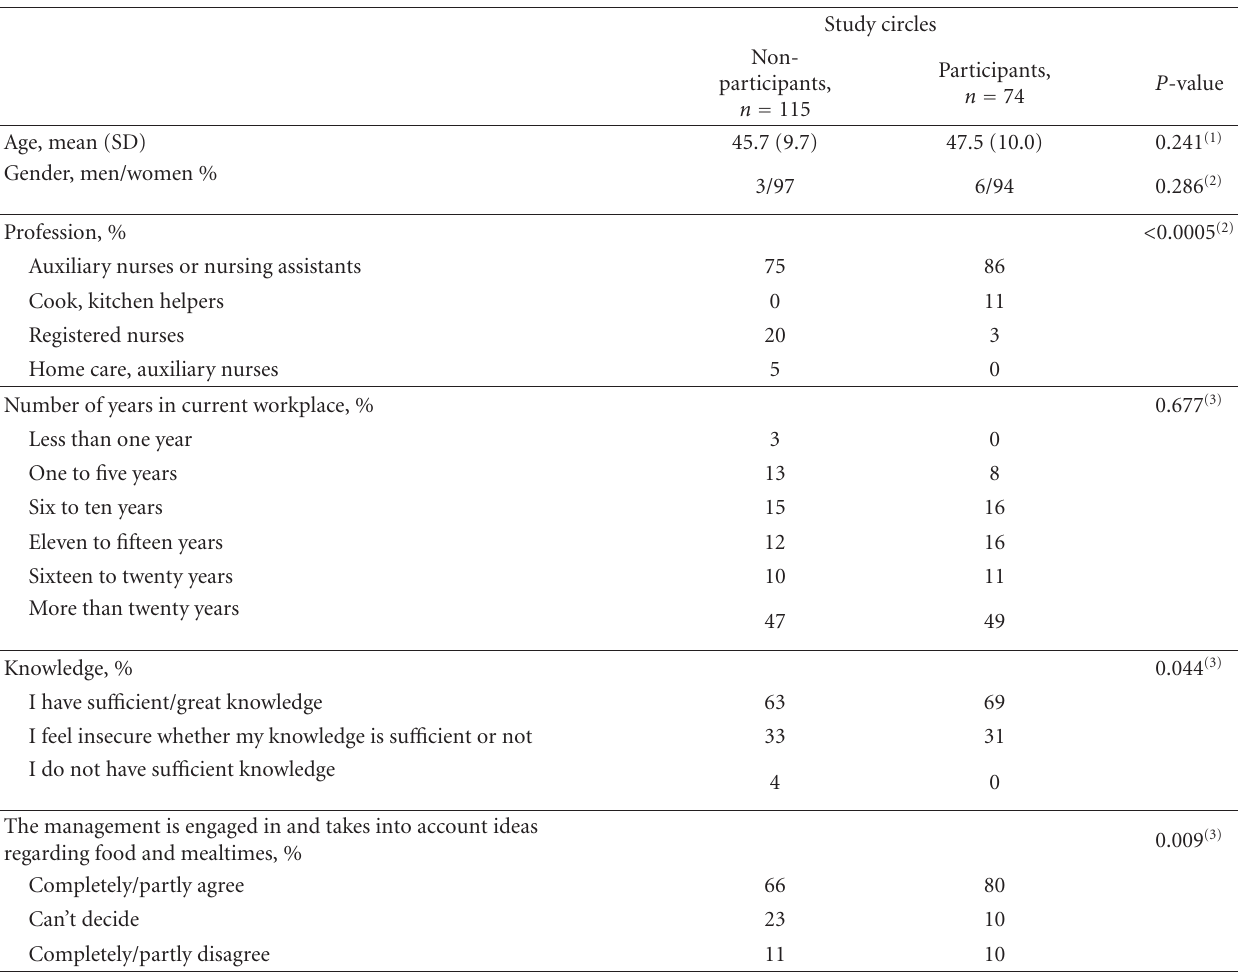
Table 5: Comparisons between sta ff members who had participated in study circles ( n = 74) and those not ( n = 115).